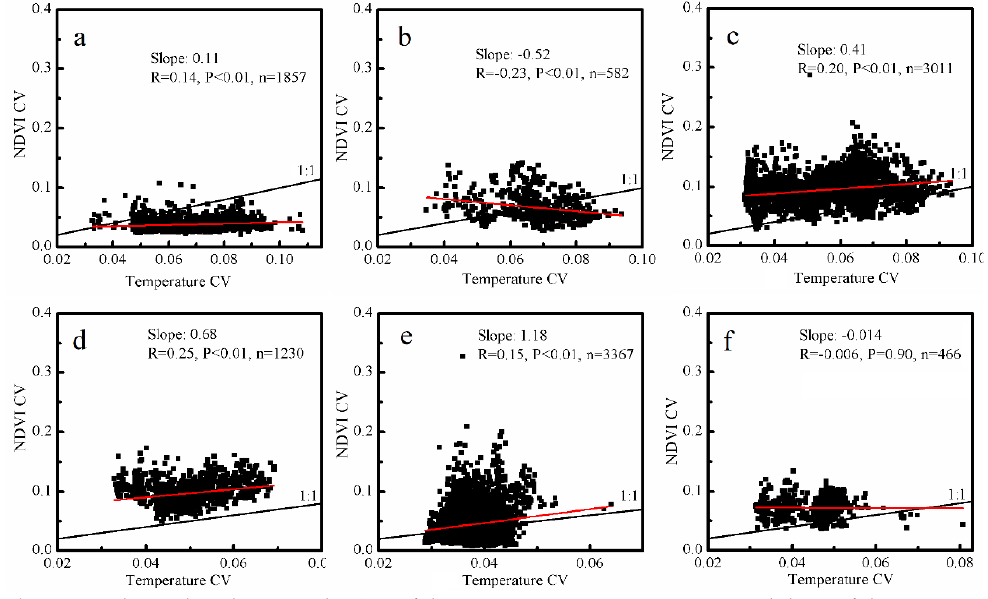
Figure 5. Relationships between the CVs of the growing season temperature and those of the NDVI in Inner Mongolia during 1982–2015: ( a ) forest, ( b ) meadow steppe, ( c ) typical steppe, ( d ) desert steppe, ( e ) desert, and ( f ) crop.